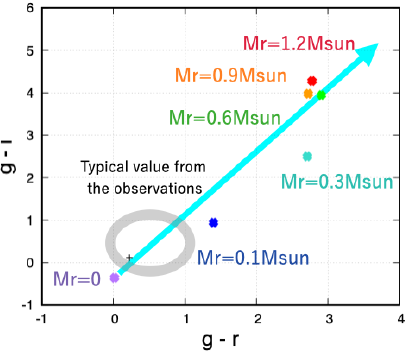
Figure 4. The event rate and the mass of r- process elements produced in one